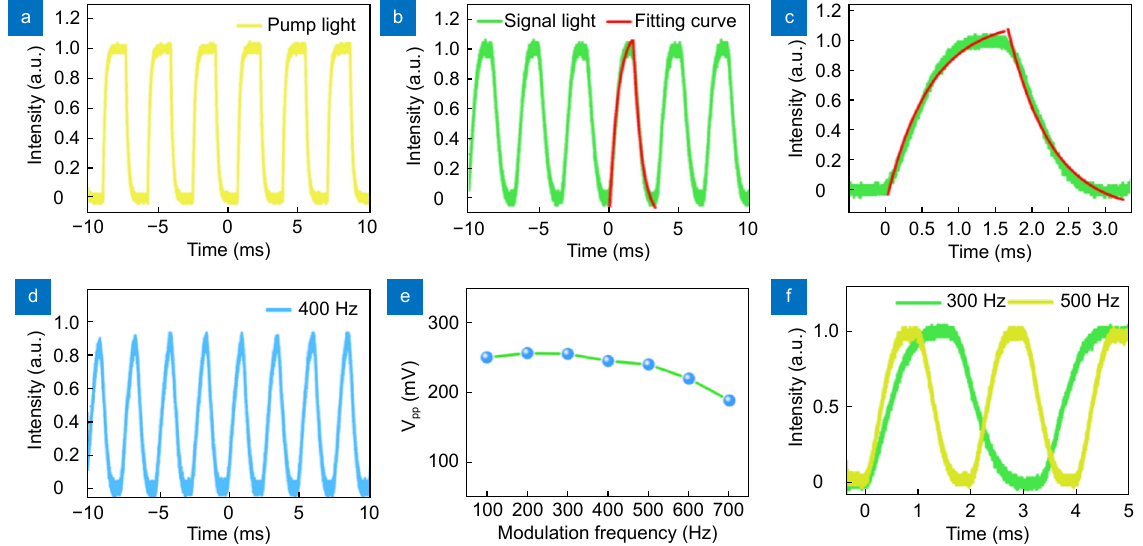
Fig. 4 | All-optical intensity modulation. ( a , b ) Waveform of control light and signal light at the modulation frequency of 300 Hz. ( c ) A single on–off transition of the signal light and corresponding fitting curve. ( d ) Waveform of signal light at the modulation frequency of 400 Hz. ( e ) V pp versus modulation frequency. ( f ) Waveform of signal